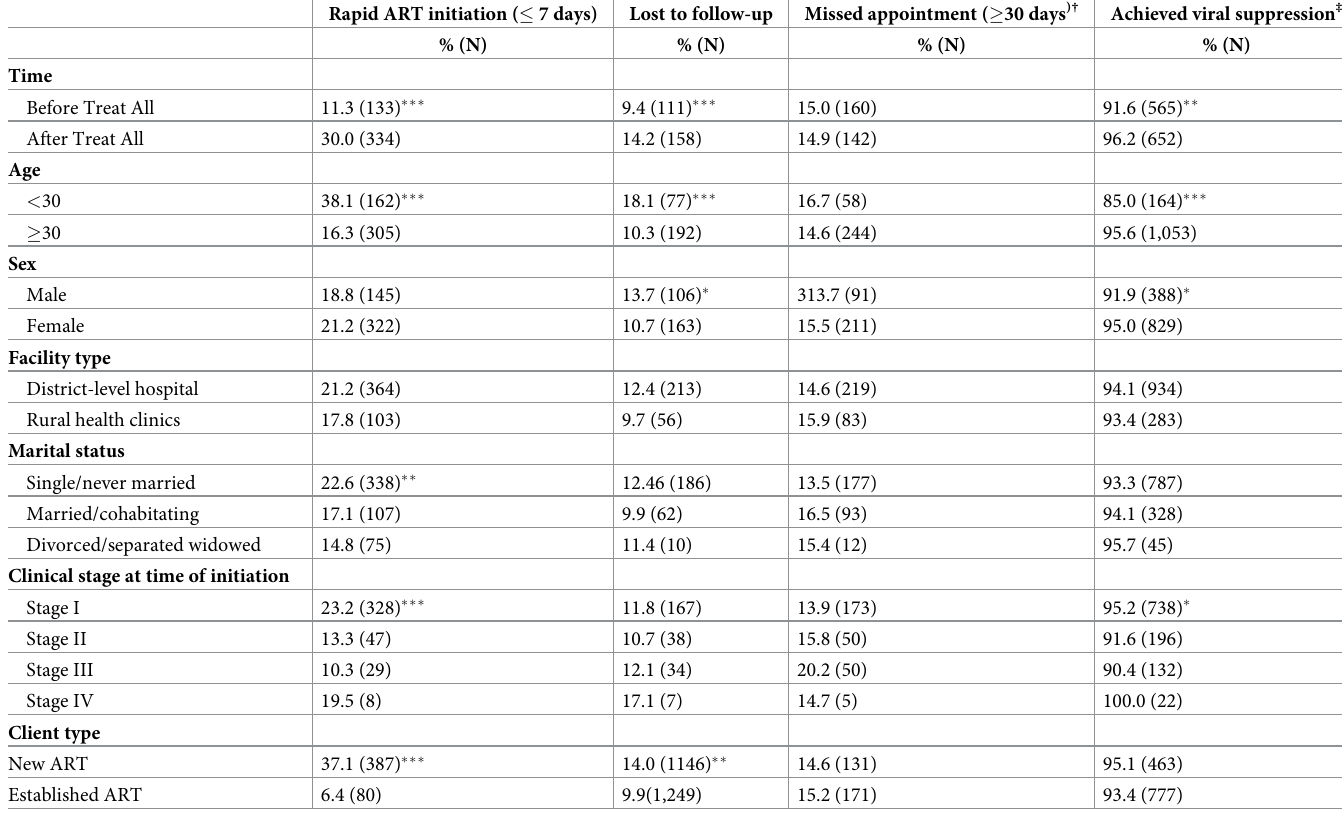
Table 3. Factors associated with key ART outcomes (bivariate level).